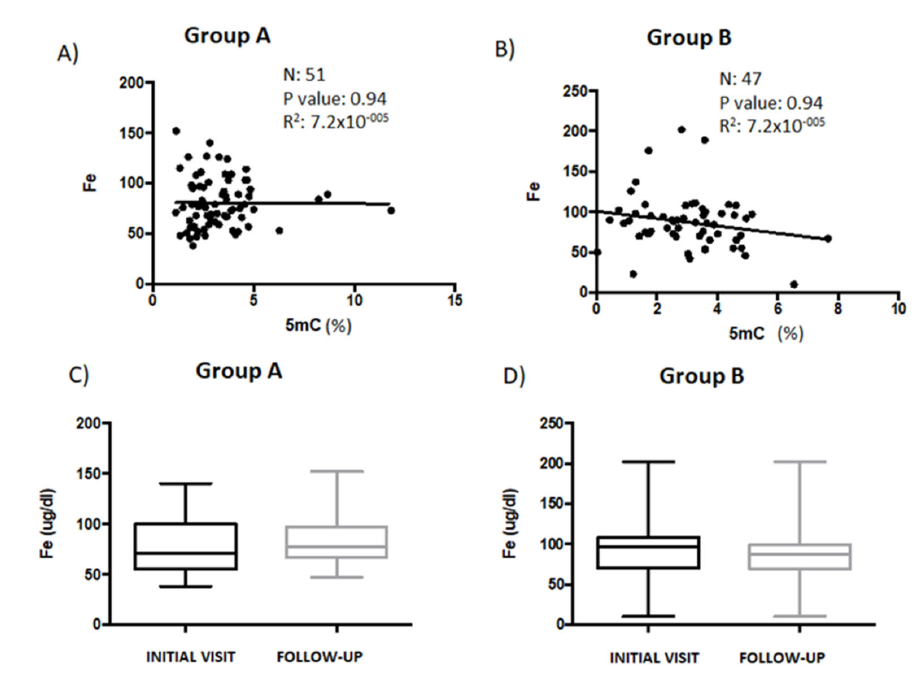
Figure 2. The relationship between Fe levels and global DNA methylation in patient serum samples. ( A ) Correlation analysis to test the association between Fe and 5mC levels in serum samples from patients in Group A ( n = 51) and ( B ) from patients in Group B ( n = 47). Fe levels measured during the initial ‐ and follow ‐ up visits were compared between patients in ( C ) Group A and ( D ) Group B. Data are presented as the mean ± S.E.M; paired t test. 5mC, 5 ‐ methylcytosine; Fe, iron. Folate is critical for generating S ‐ adenosylmethionine (SAM), a key donor in reactions necessary for the methylation of DNA [37]. In the current study, there was a significant positive correlation ( p = 0.0466) between folate and 5mC levels in patients (Group A) whose 5mC levels were higher during the follow-up visit than during the first consultation (Figure 3A). However, 5mC and folate levels were negatively correlated ( p = 0.0272)